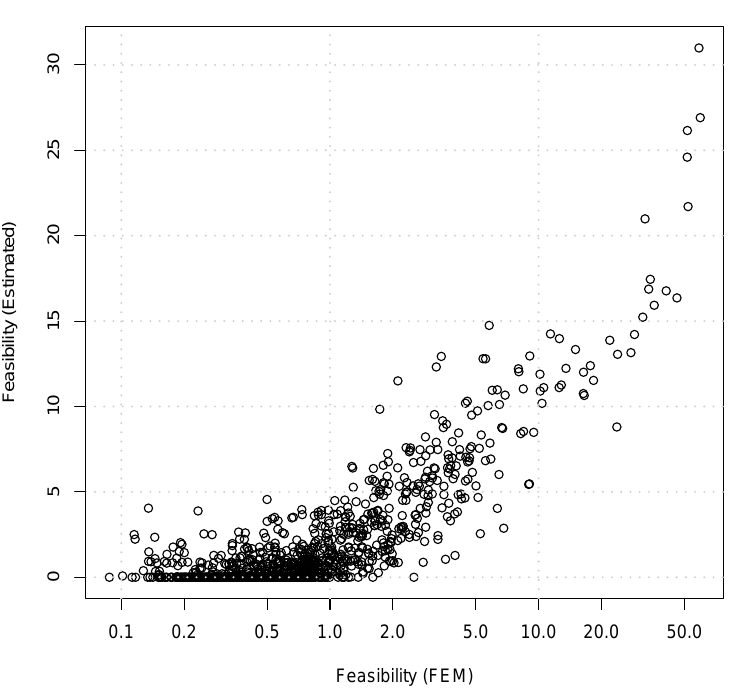
Figure 13. Feasibility index values computed by FE and the